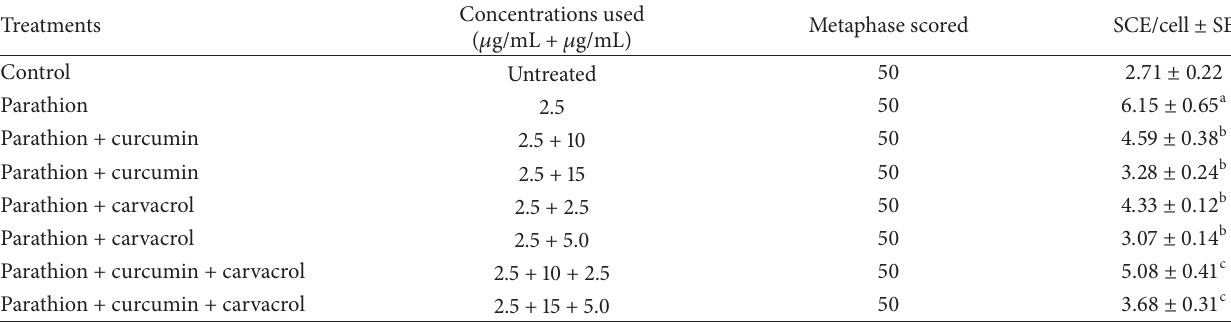
Table 4: Combined effect of curcumin and carvacrol against parathion treated cultured human peripheral blood lymphocytes. Treatments